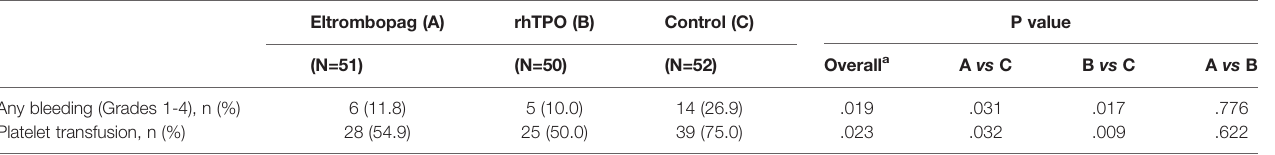
TABLE 4 | Bleeding by WHO grades and platelet transfusion after treatment.